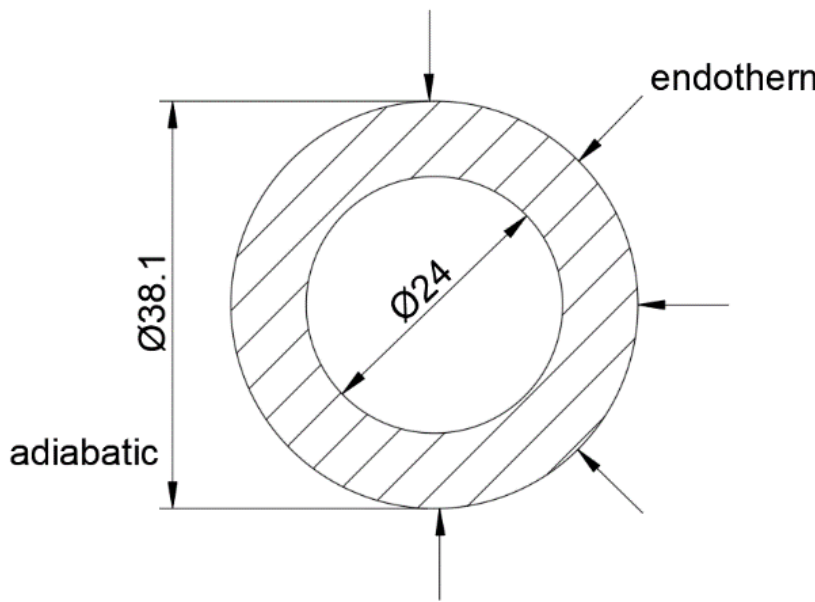
Figure 5. Section diagram of the lower vertical tube. The cooling wall vertical tube is based on an adiabatic half side, a half side with the heat exchange of flue gas, and heat flux (q = UDF) according to the local heat exchange formula; the extended tube length distribution is shown in Figure 6.